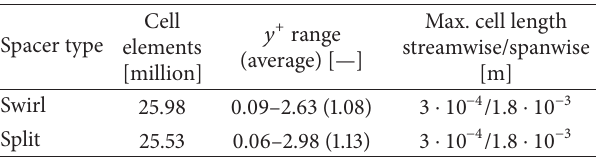
Table 1: Mesh detail summary. Spacer